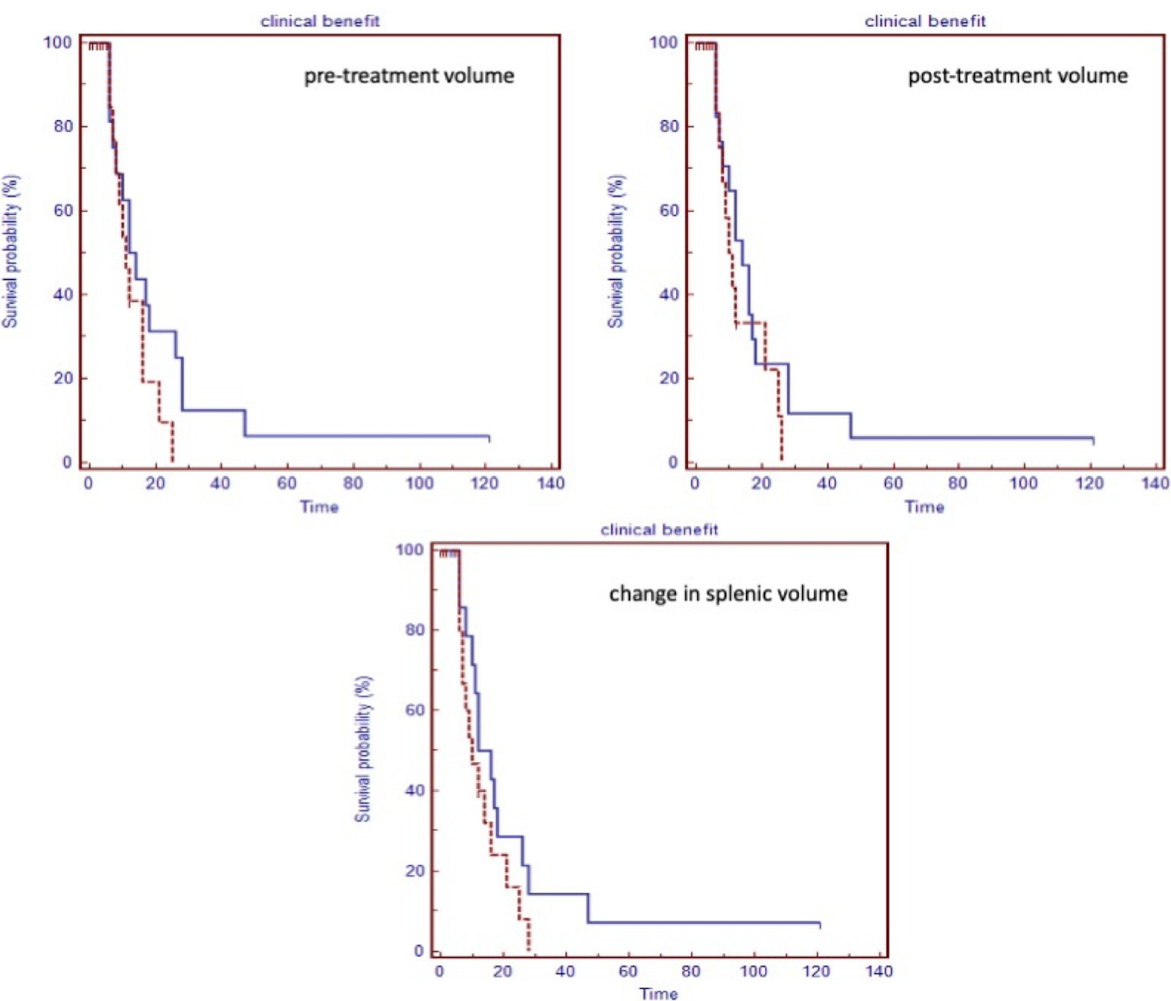
Fig 4. Kaplan-Meier curves for time to disease progression. The Kaplan-Meier curves show the median time to progression between patients with clinical benefit to treatment versus those without benefit to treatment stratified using the median pre-treatment splenic volume, post-treatment splenic volume and change in splenic